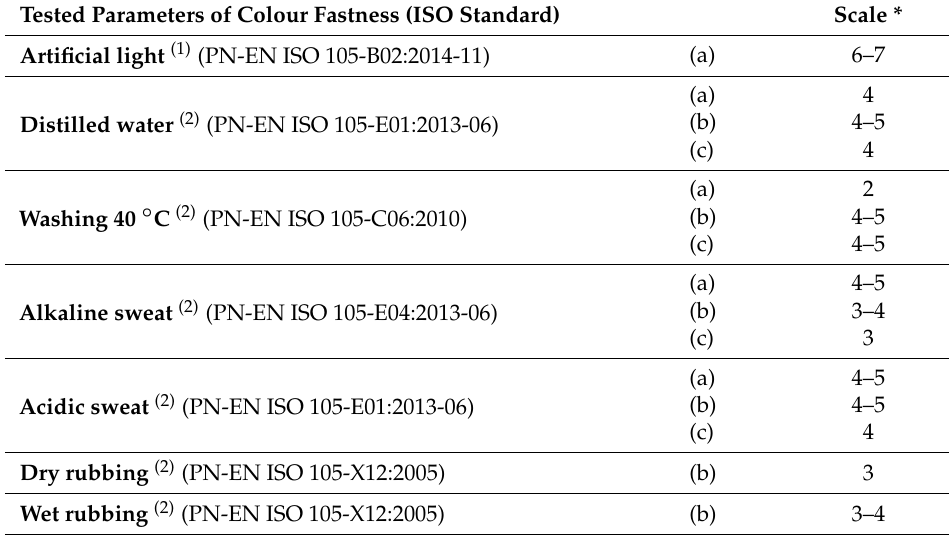
Table 6. Colour fastness of wool fibres dyed with the use of the dye obtained through the LAC- mediated ANS oxidation.